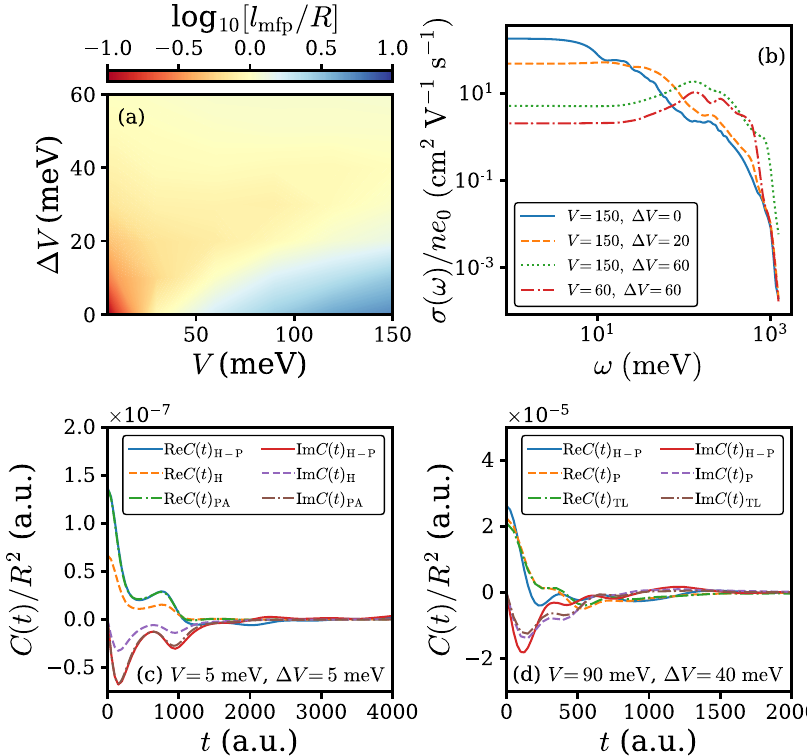
Fig. 2 Further analysis of the transport regimes. a Carrier mean free path l mfp / R at 300 K for the Holstein-Peierls model at various transfer integral V and transfer integral fl uctuation Δ V . In the blue region (bottom right) the carrier mean free path exceeds the lattice constant R . b Per carrier optical conductivity of the Holstein – Peierls model at various transfer integral V and transfer integral fl uctuation Δ V . c , d Correlation functions obtained from our simulation with Holstein-Peierls model C ( t ) H-P , pure Holstein model C ( t ) H and pure Peiels model C ( t ) P as well as the correlation function obtained from